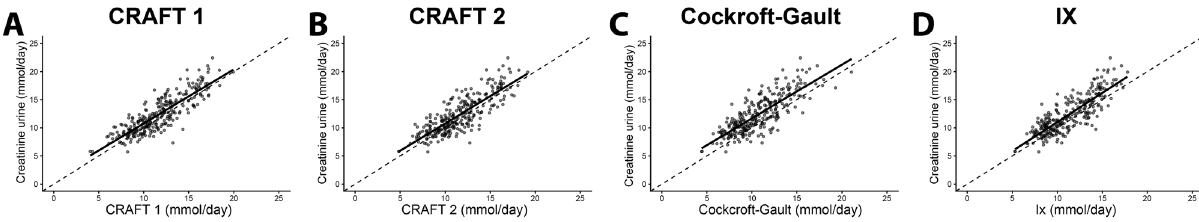
Figure 4. Plots comparing the CRAFT 1 ( A ), CRAFT 2 ( B ), Cockcroft-Gault ( C ), and Ix equation ( D ) to creatinine excretion in the kidney donor dataset. Solid regression lines in dot plots are calculated with ordinary least squares regression. The dashed line is the line of